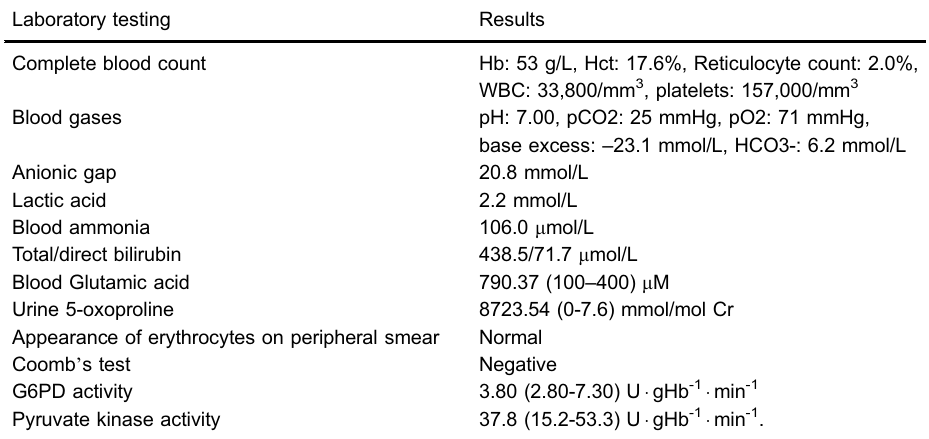
Table 1. Laboratory fi ndings on Day of Life